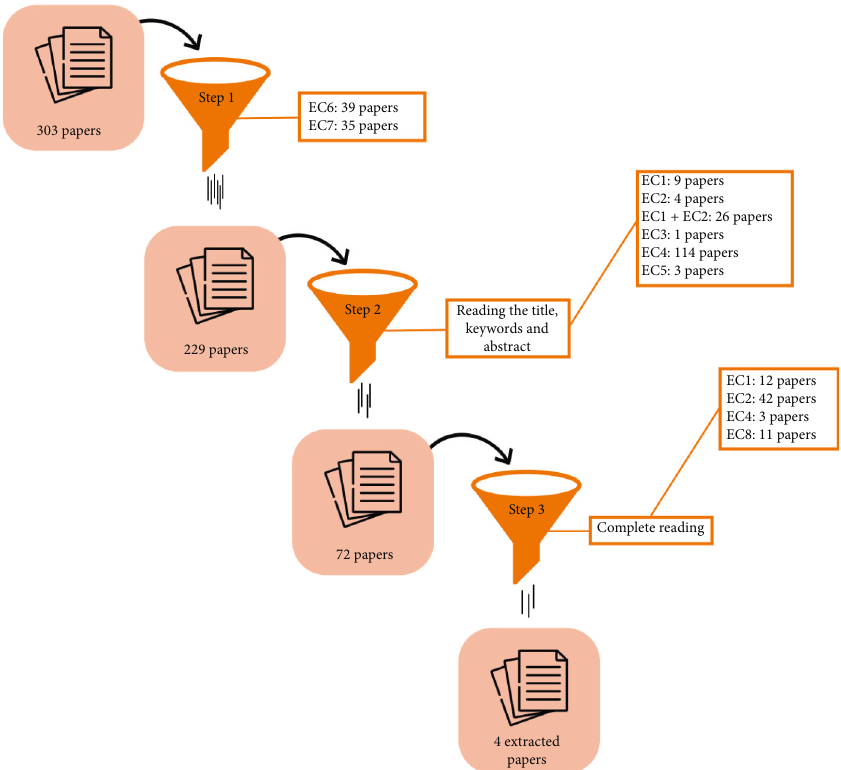
Figure 2: Papers selection process with snowballing.